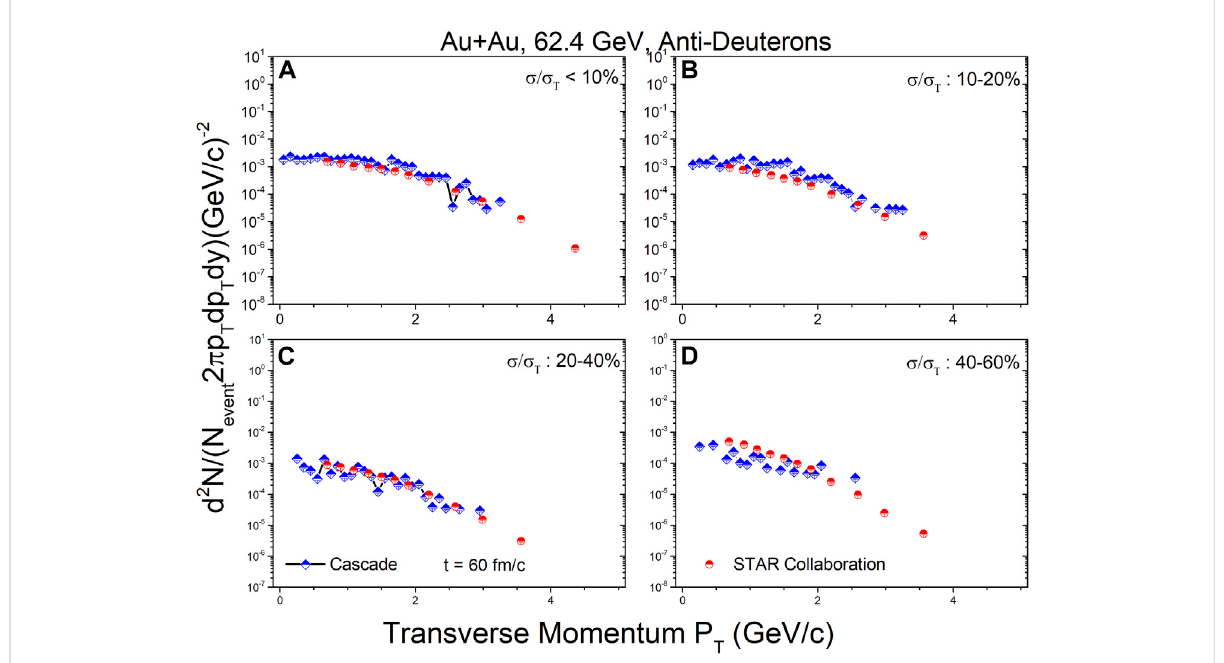
(cid:1)(cid:1)(cid:1)(cid:1) √ s NN In the = 62.4 GeV Au + Au collisions, 0, − ,10%, 10, − ,20%, 20, − ,40%, 40, − ,60% and 60, − ,80% centrality in t = 60 fm / c in the anti- deuteron transverse momentum spectrum. Calculations are represented by signs + lines. Experimental data from the STAR collaboration [27] are represented as circles. The parameter sets of ( R 0 , P 0 ) is (3.8 fm, 0.3 GeV/ c ).